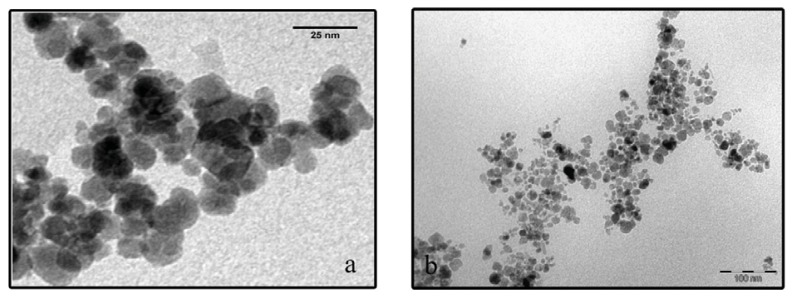
TEM images of (a) Fe3O4 and (b) MO-20.